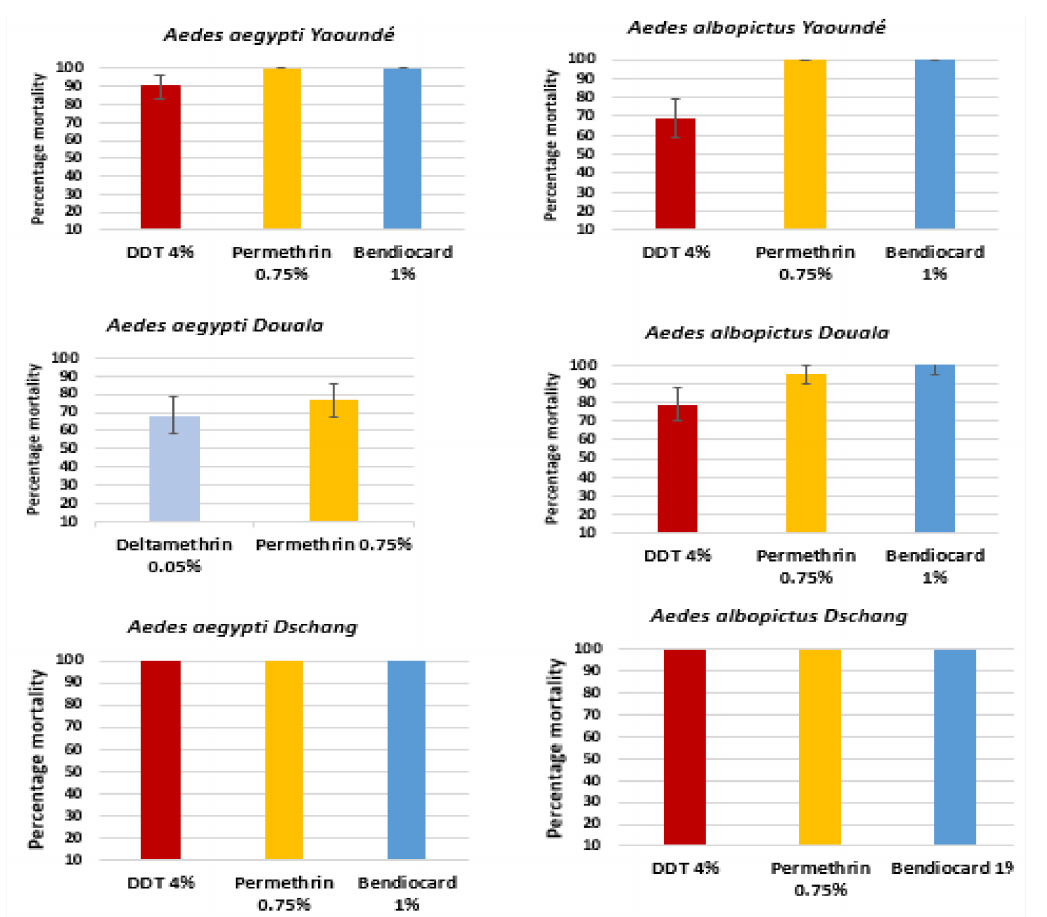
Figure 2. Susceptibilities profiles of Aedes aegypti and Aedes albopictus in Yaound é , Douala and Dschang. Error bars represent 95% confidence intervals. Table 2. Frequency of kdr resistance alleles in different populations of Ae. aegypti